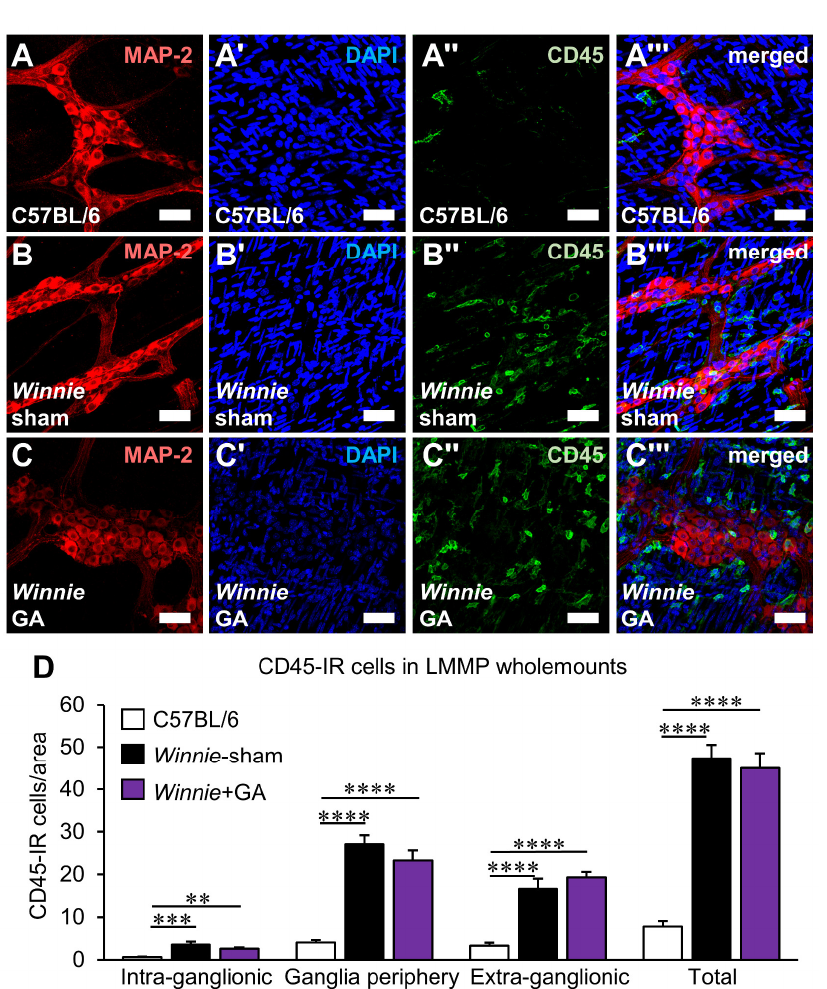
Figure 8. Effects of glycyrrhizic acid treatments on leukocyte numbers in proximity to myenteric neurons in the distal colon of Winnie mice. ( A – C”’ ) Leukocytes in proximity to the myenteric ganglia were observed by immunofluorescence of the neuronal marker MAP-2 ( A – C ), nuclear stain DAPI ( A’ – C’ ), the pan-leukocyte marker CD-45 ( A” – C” ) and merged images ( A”’ – C”’ ) in LMMP whole-mount preparations from the distal colon of C57BL/6 mice ( A – A”’ ), sham-treated Winnie mice ( B – B”’ ) and Winnie mice treated with glycyrrhizic acid (GA) ( C – C”’ ) (scale bar = 50 µ m). ( D ) Quantification of CD-45-IR cells per area. Leukocytes were categorised as residing in the intra-ganglionic region, the periphery of the ganglia or the extra-ganglionic region. ** p < 0.01, *** p < 0.001, **** p < 0.0001; n = 6